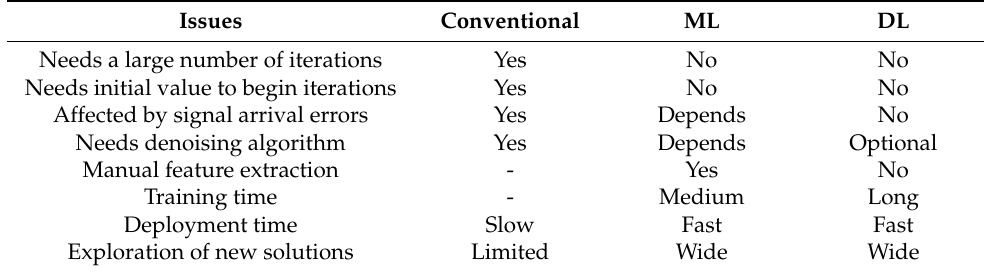
Table 7. Comparison of PD localization